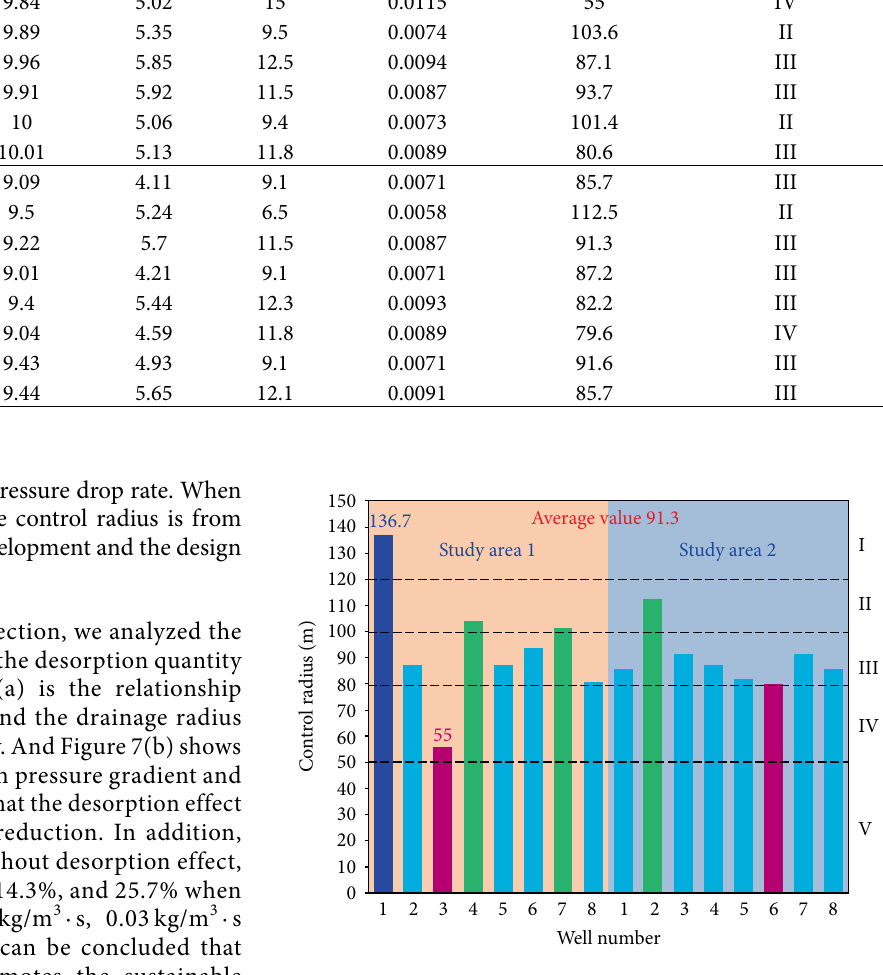
Figure 8: The histogram of the control radius